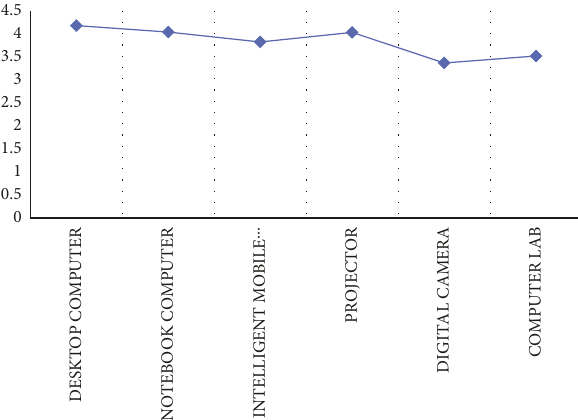
Figure 6: Survey on frequency of teachers’ use of equipment in